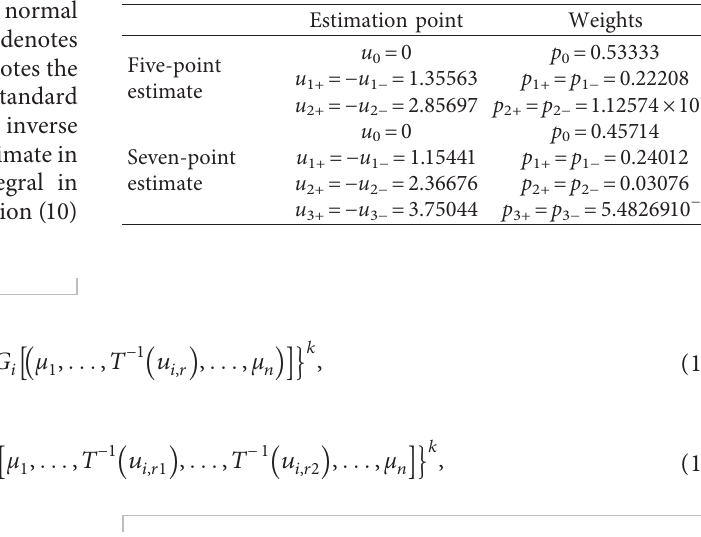
Table 1: Five- and seven-point estimates corresponding to the estimating point and